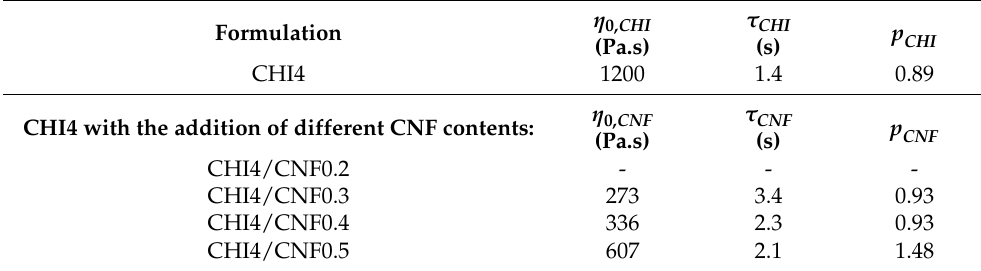
Table 2. Flow parameters determined from the fitting of the viscosity vs. shear rate curves of different CHI/CNF collodion formulations (Figure 3), by using the Cross model (Equation (1)) for naked CHI solution and a double Cross model (Equation (2)) for CHI/CNF formulations.